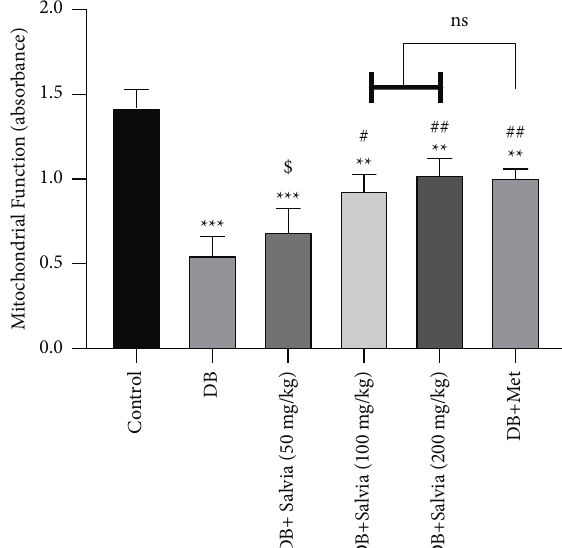
Figure 8: Effect of Salvia spinosa extracts on mitochondrial function in renal isolated mitochondria in streptozotocin-induced diabetic mice. Control: normal mice, DB: diabetic mice, DB +Salvia: diabetic mice given the methanolic extract of Salvia spinosa , and DB +Met: diabetic mice given metformin (500mg/kg). Values represented as mean ± SD. ∗∗ P < 0 . 01 compared with control mice. ∗∗∗ P < 0 . 001 compared with control mice. # P < 0 . 05 compared with diabetic mice. ## P < 0 . 01 compared with diabetic mice. $ P < 0 . 05 compared with metformin-treated diabetic mice. Ns: